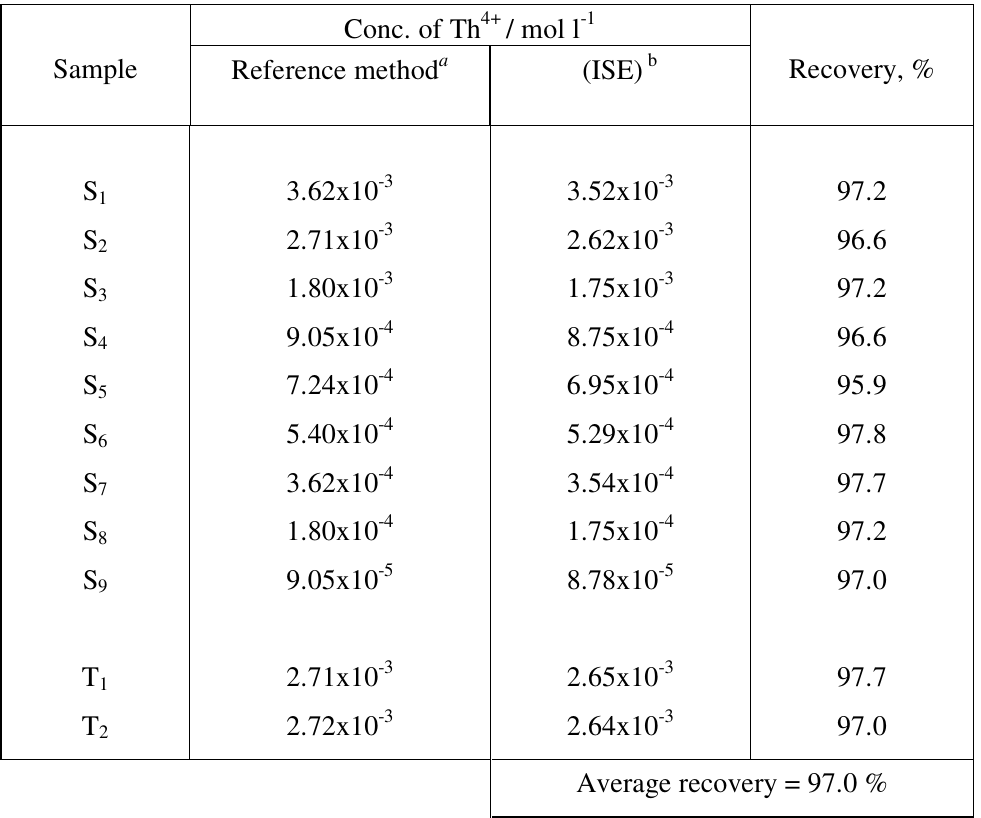
Potentiometric recovery studies on homogenous method ionophore-based coated graphite rod thorium